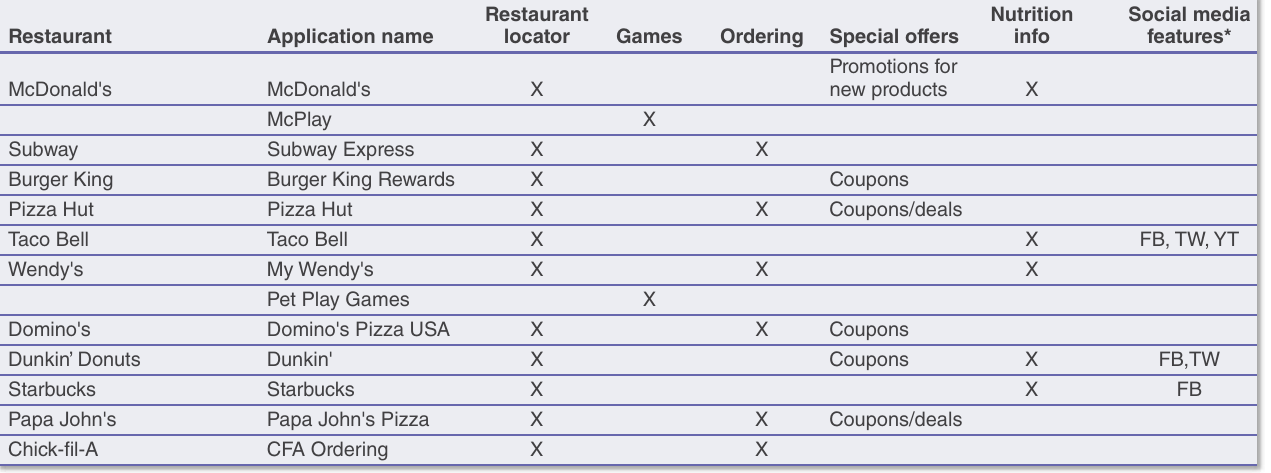
Table 35. Mobile smartphone